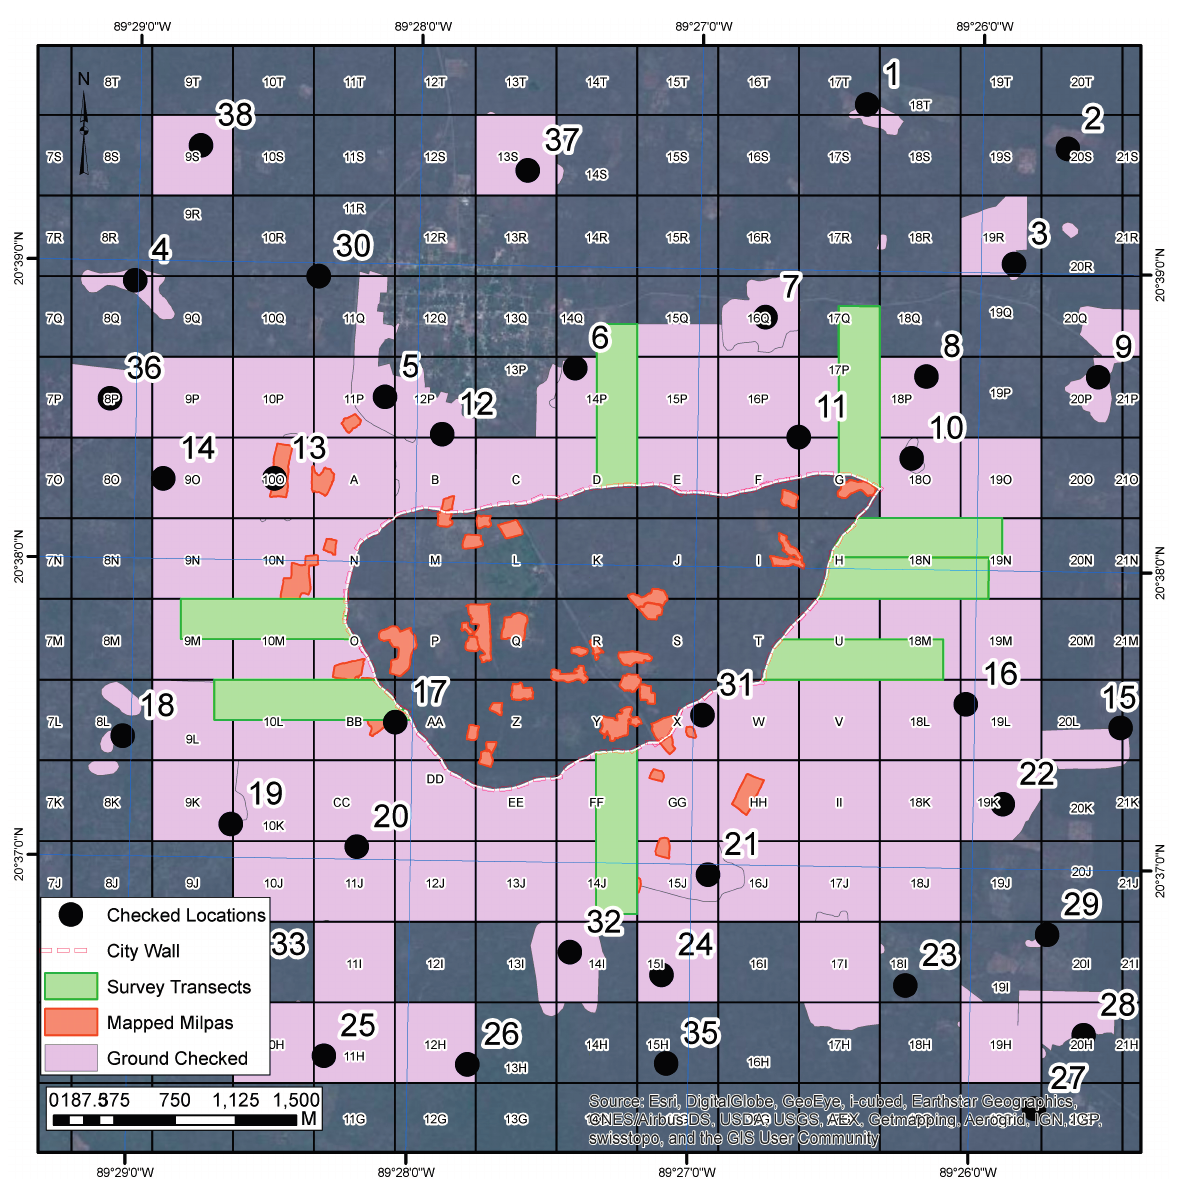
Figure 8. Map of areas checked by pedestrian survey and the intensive sample